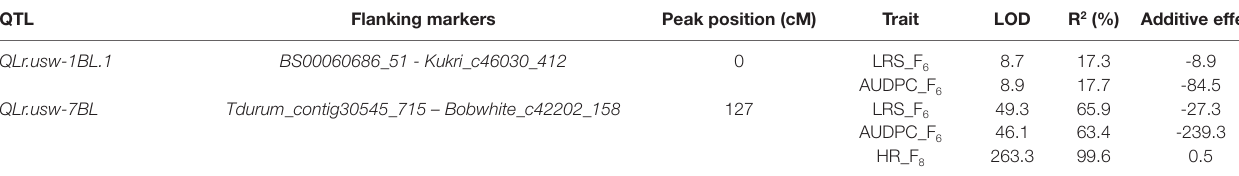
TABLE 4 | Leaf rust resistance QTL detected by CIM in the Arnacoris/ATRED #2 population. QTL Flanking markers Peak position (cM) Trait LOD